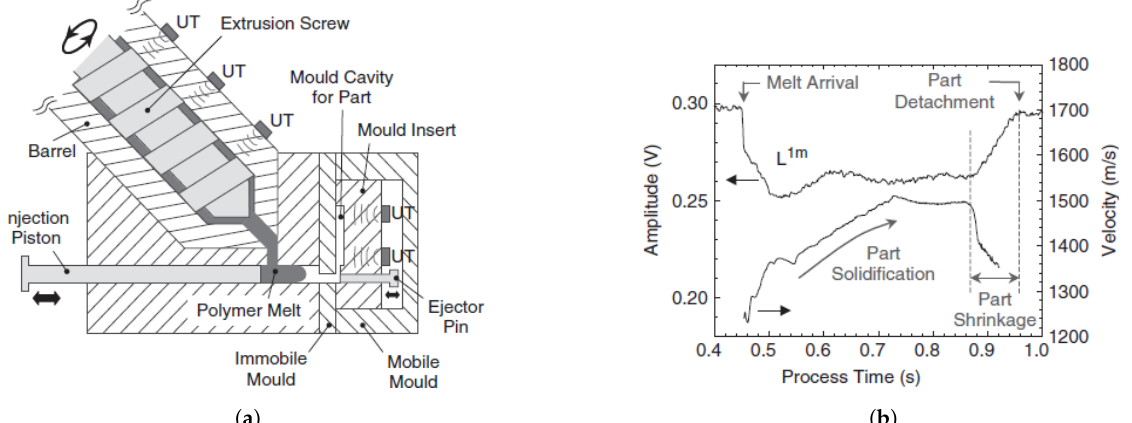
Figure 7. ( a ) Fabricated sol-gel UTs at the nozzle and Mould insert; ( b ) The velocity and amplitude of ultrasonic sensor vs. Process time